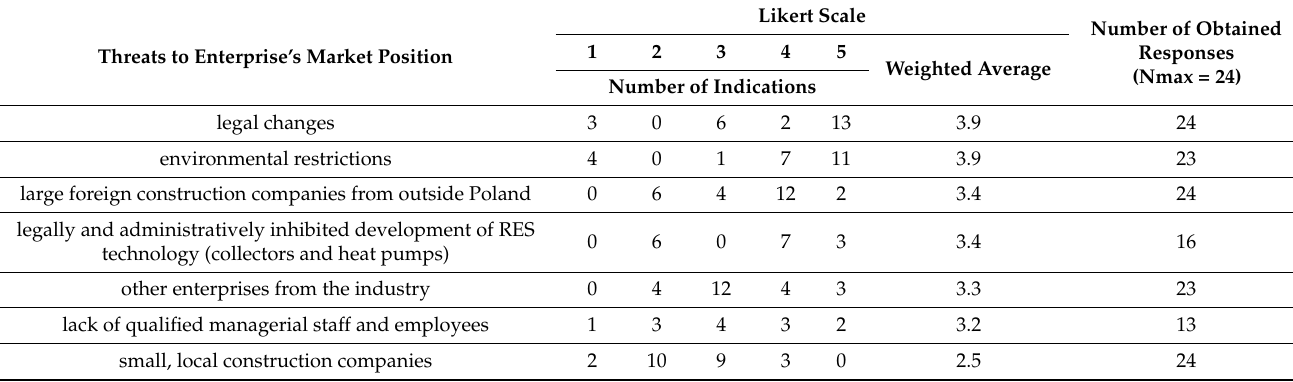
Table 6. Threats to the market position of design and construction enterprises of PV farms—Likert scale